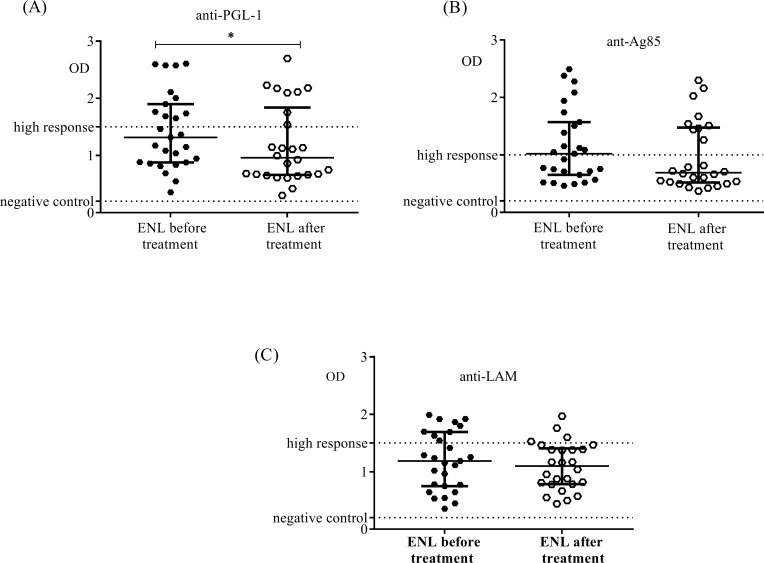
Serological responses to antigens in patients with ENL before and after prednisolone treatment (A): response to M. leprae PGL-1 antigen; (B): response to M. leprae Ag85 antigen; (C): response to M. leprae LAM antigen; Number of ENL = LL = 25; Statistical test: Mann-Whitney unpaired test (U). * P≤0.05; Error bars show median ± interquartile range.